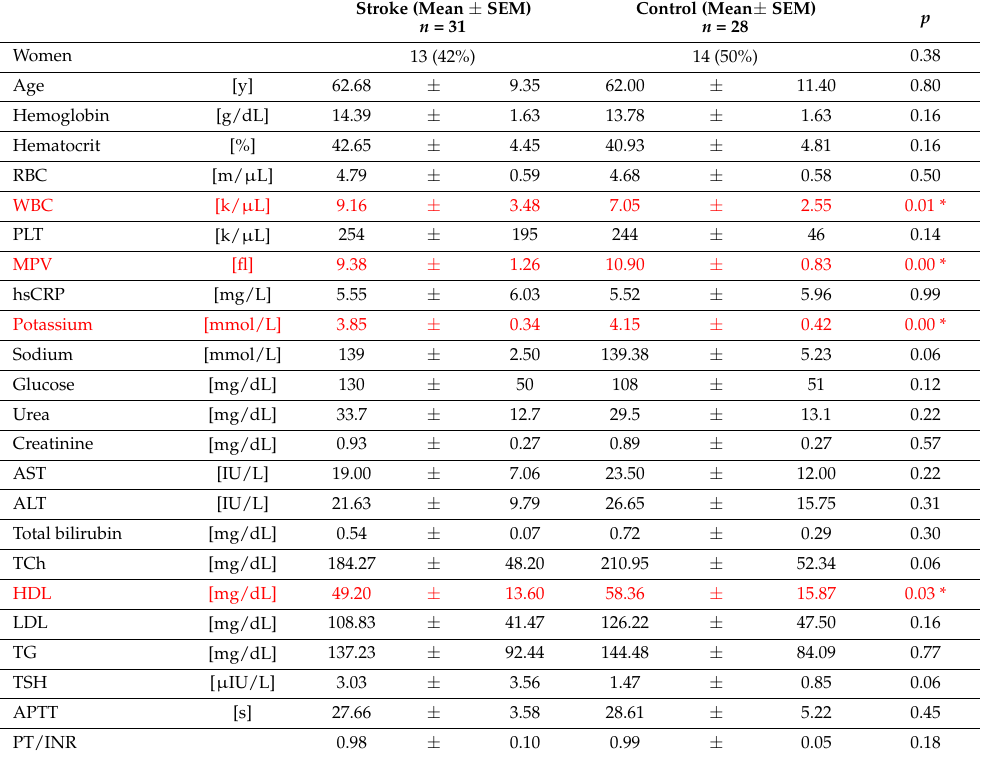
Table 1. Demographic and biochemical characteristics selected groups, with particular emphasis on cardiovascular risk factors.